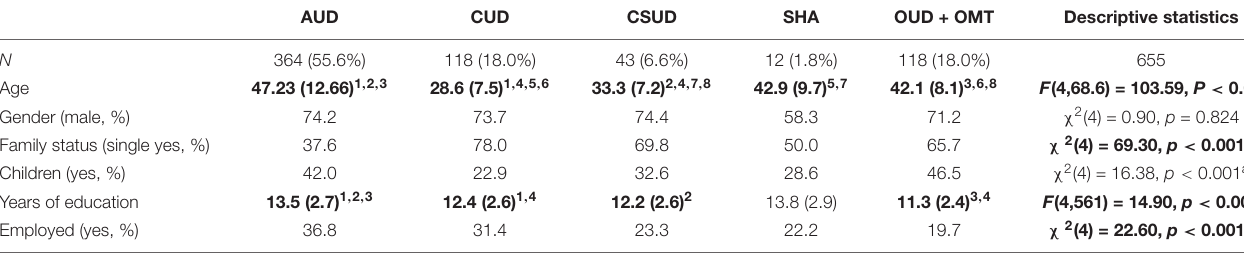
TABLE 1 | Sociodemographic data of the overall sample. AUD CUD CSUD SHA OUD + OMT